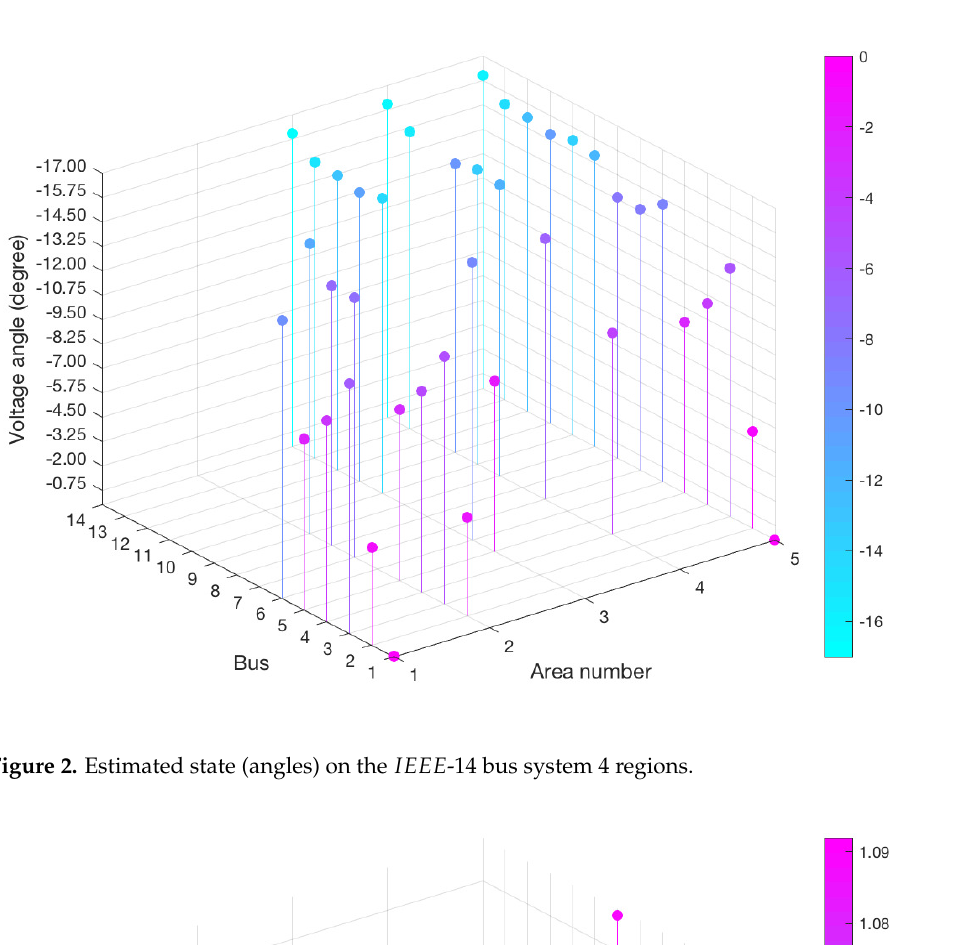
Figure 2. Estimated state (angles) on the IEEE -14 bus system 4 regions.